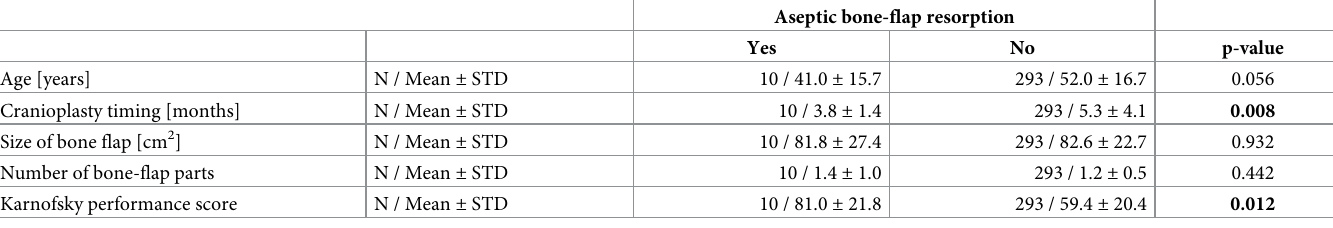
Table 3. Descriptive statistics and results of unadjusted tests for ABFR for continuous variables.